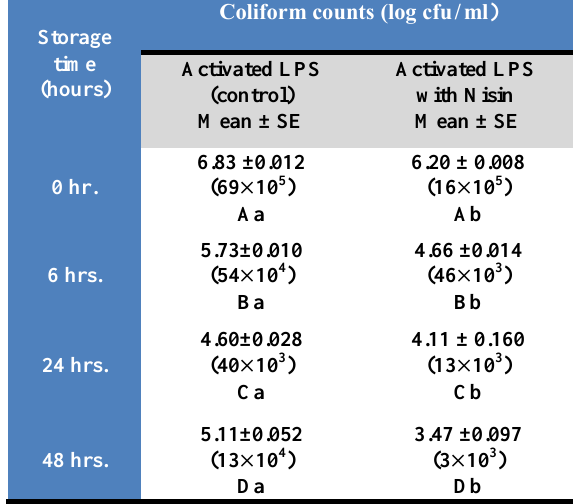
Table, 3: The action of Nisin (50IU/ in co bination with acti